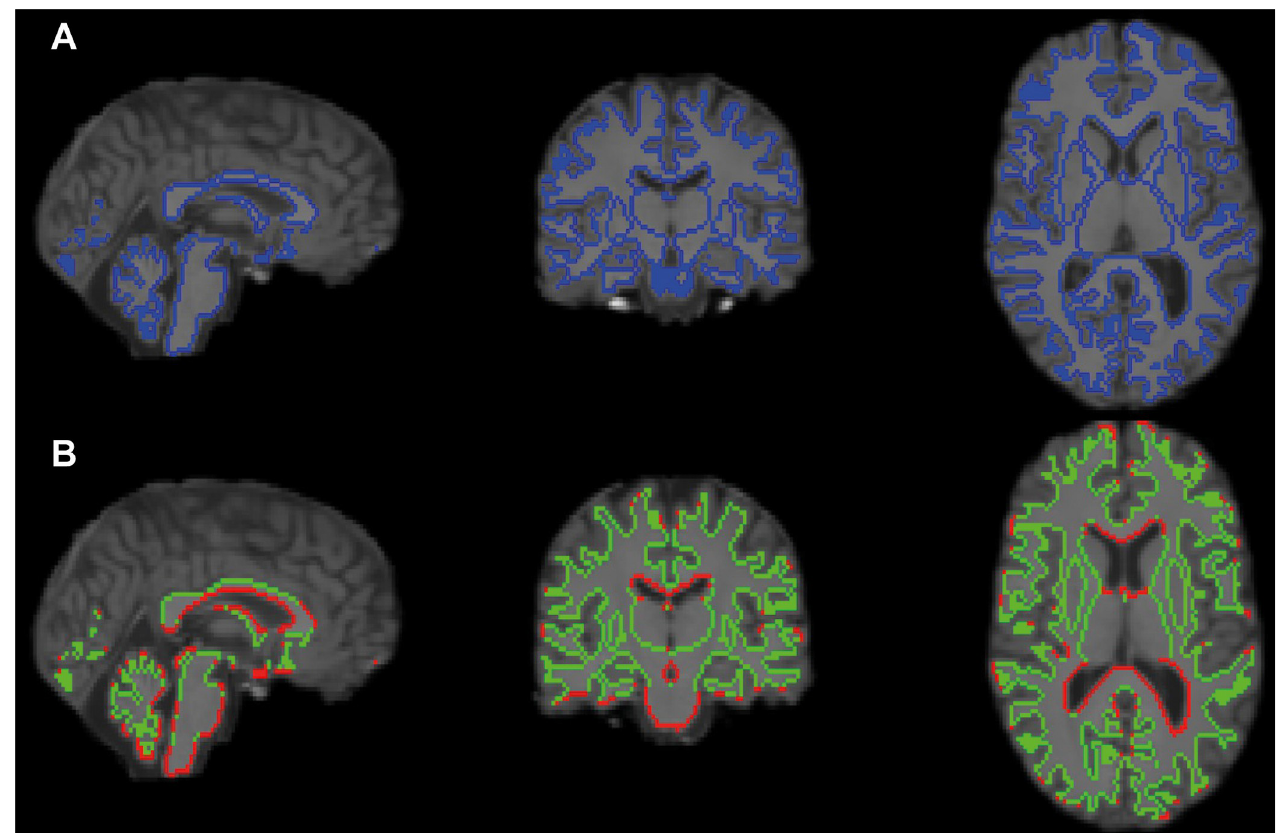
Fig 3. Example of boundary segmentation. A) Boundary of the WM. The blue line is the binary mask. The T1 image is in native diffusion space. B) Boundary of the WM/CSF and WM/GM. The red line is the mask of the WM/CSF boundary and the green line is the mask of the WM/GM boundary. The T1 image is in native diffusion